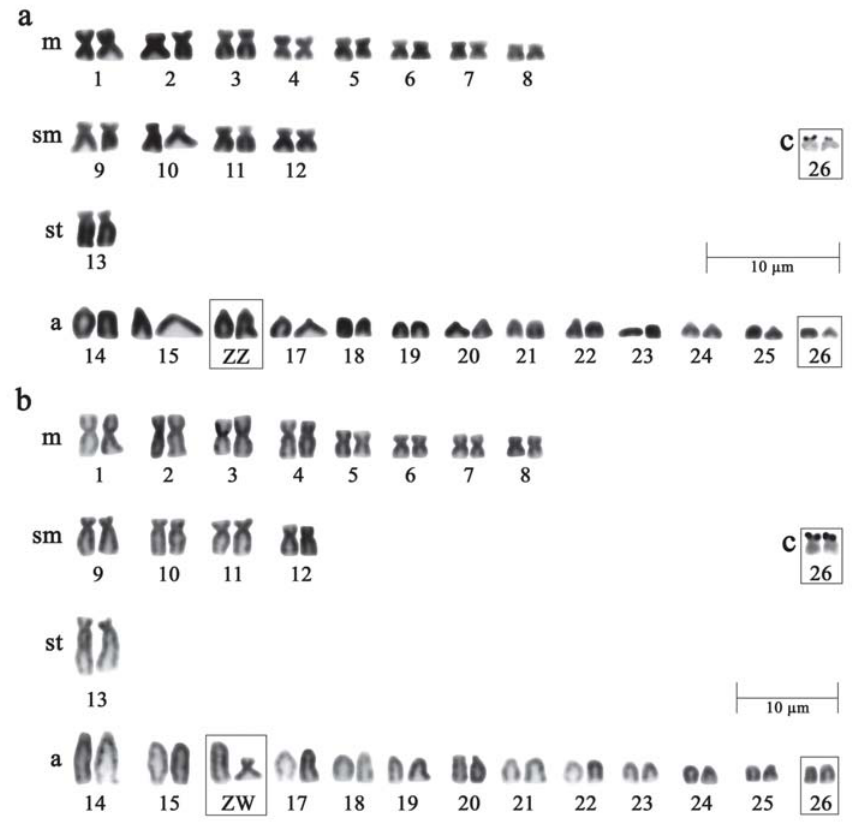
Fig. 3. Karyotypes of male (a) and female (b) Ancistrus sp. “Piagaçu” after conventional Giemsa-staining, evidencing the sex chromosomes (box) and the NOR-bearing chromosomes after silver-staining (c). m= metacentric; sm= submetacentric; st= subtelocentric; a=